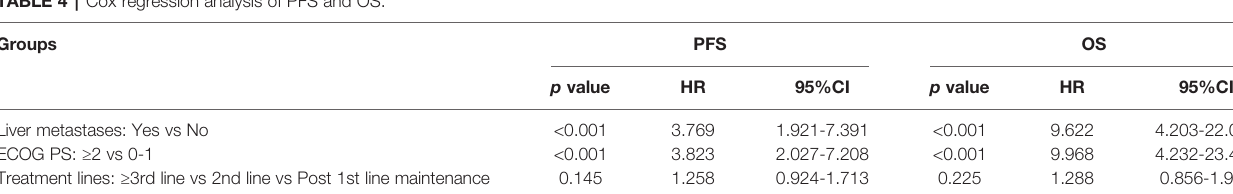
TABLE 4 | Cox regression analysis of PFS and OS.